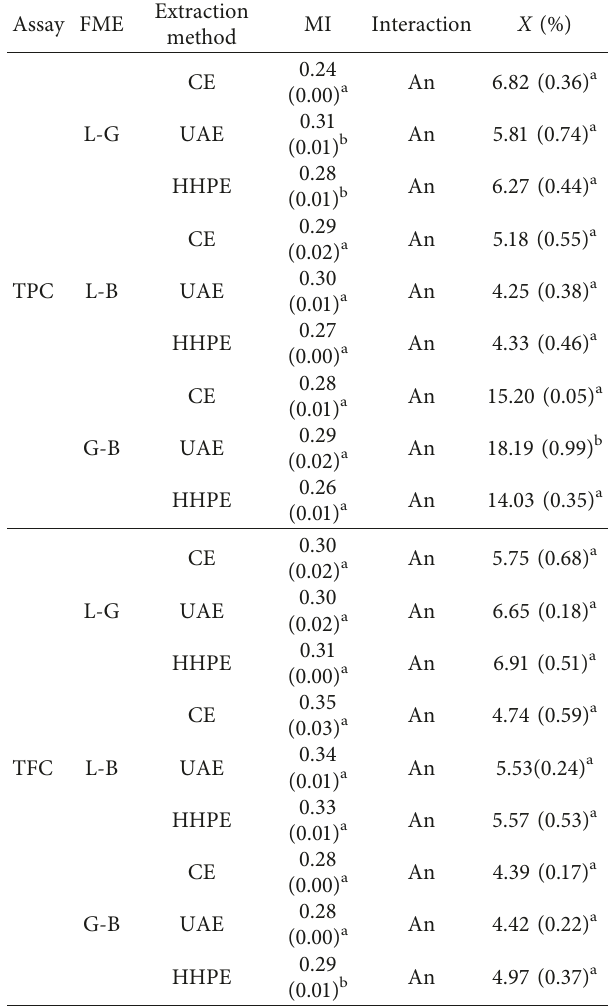
Mean values of extraction methods with different superscript letters (a–c) in rows were significantly different ( p < 0 . 05) by Fisher’s test. Mean and standard deviation are presented in brackets. Table 5: Mixture index (MI) and regeneration percentage of TPC and TFC assays from fruit